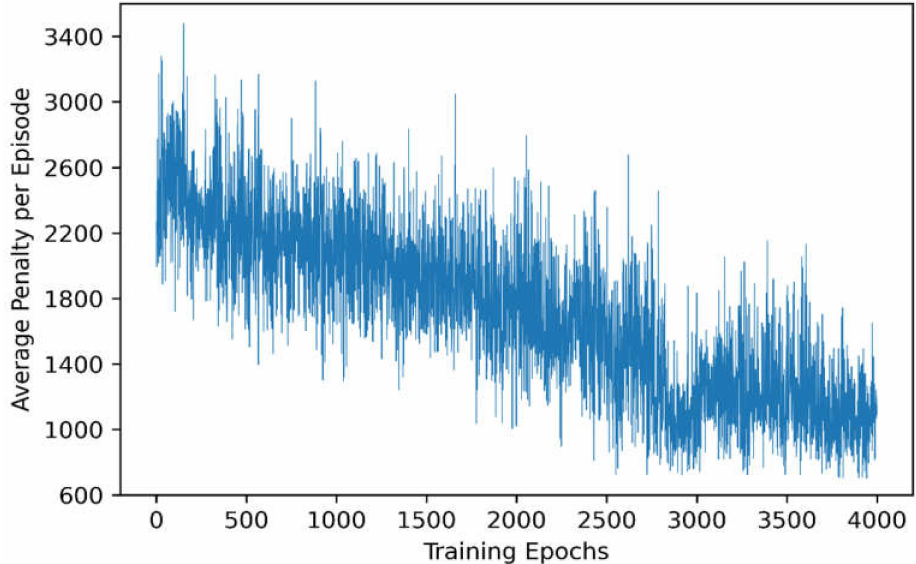
Figure 2. Average earliness and tardiness penalty at each training epoch.